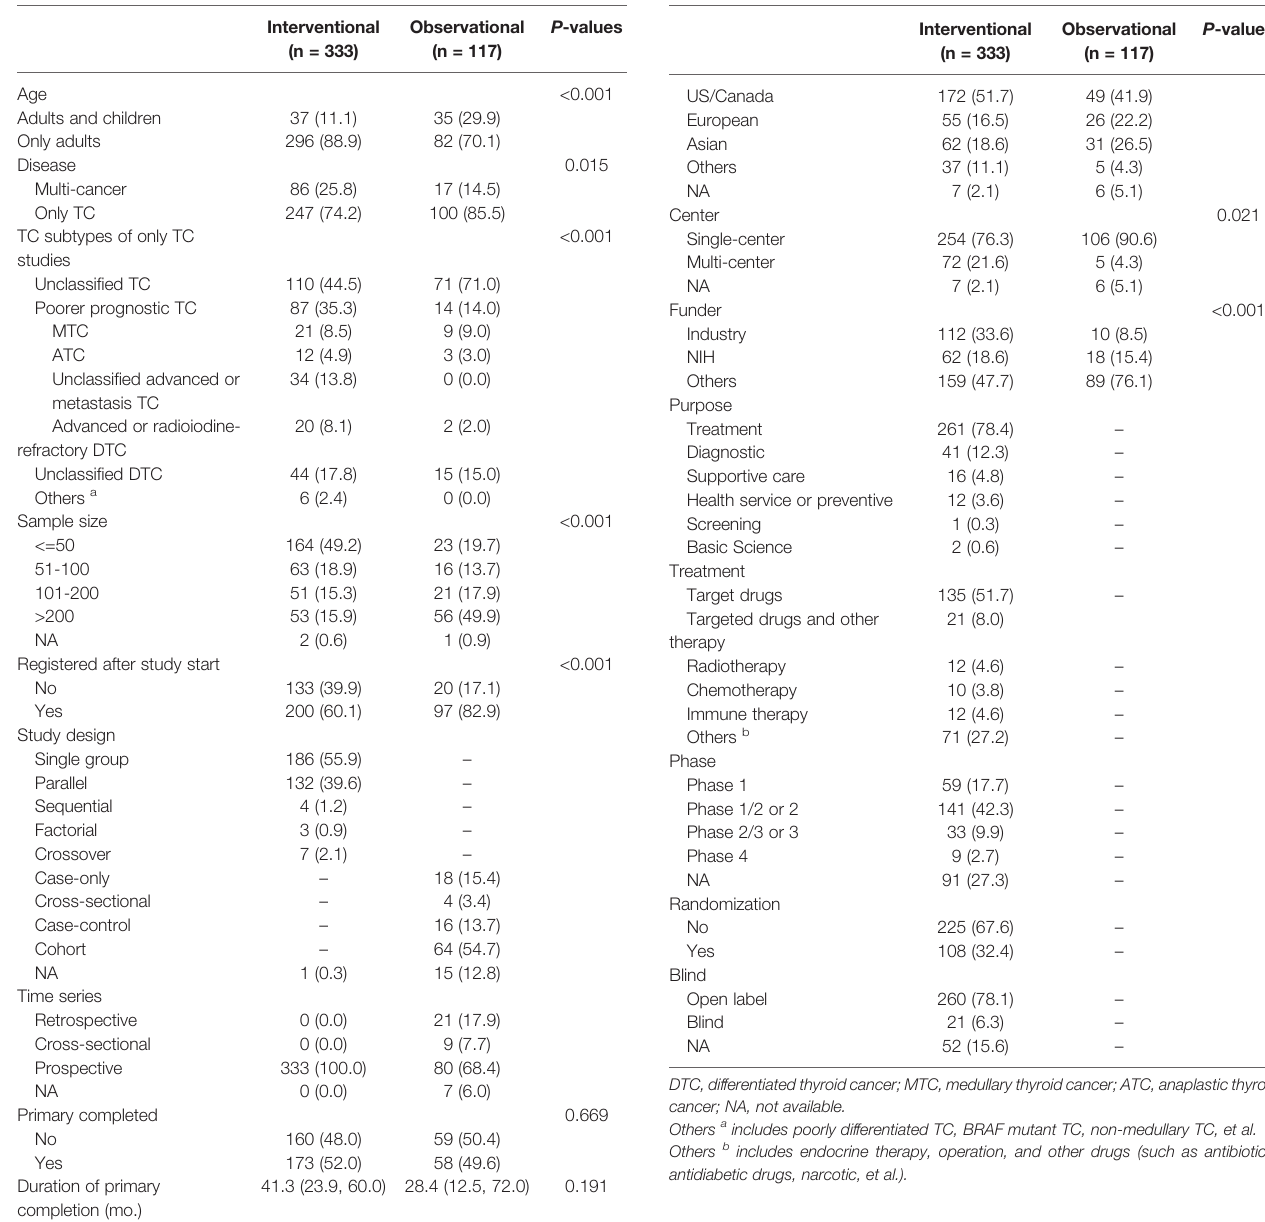
TABLE 1 | Characteristics of interventional and observational